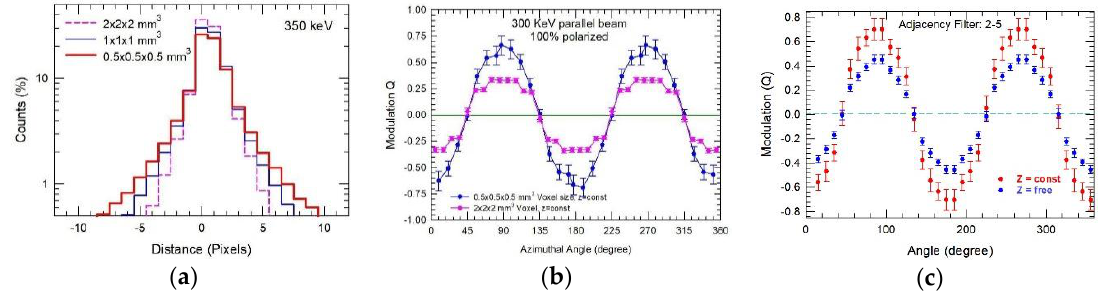
Figure 9. ( a ) The distribution of the distance in the XY plane (in pixel units) between the hits of Compton events as function of the sensitive volume discretization; ( b ) Modulation curve for two different discretization in voxel of the same sensitive volume obtained by selecting scattered events for which the two hits have the same coordinate in z (along the detector thickness); and, ( c ) Modulation curves obtained with voxel of 0.5 × 0.5 × 0.5 mm 3 for a parallel monochromatic beam at 300 keV considering all the detected (blue) double events ( z = free) and double events for which the two hits have the same coordinate in pixel units along the z-axis (z=const). In both cases, the double events are filtered considering only events with hits distances in the detector plane (i.e., adjacency) between two and five pixels.